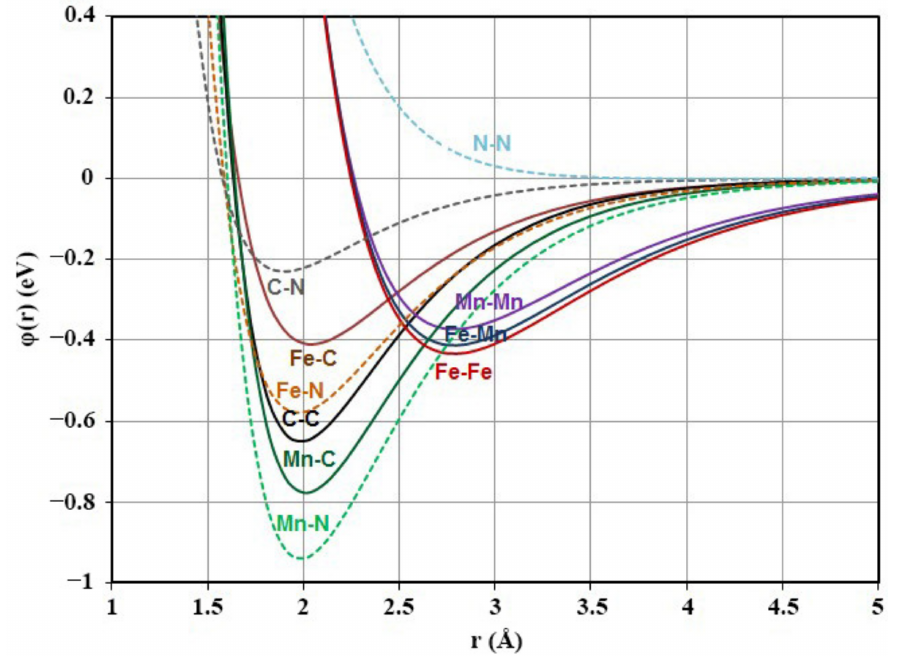
Figure 2. Morse potentials for bonds in the γ Fe-Mn-C-N system (the potentials describing interactions with a nitrogen impurity are shown by a dotted